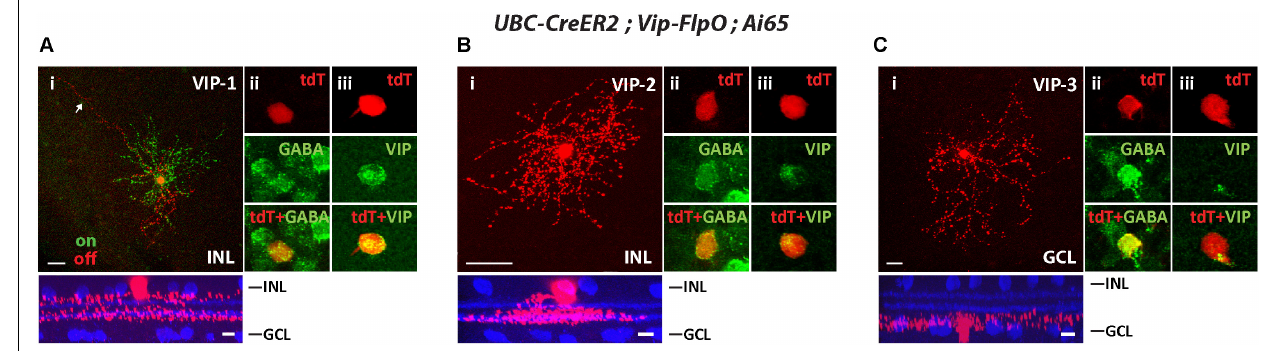
FIGURE 5 | The Vip-FlpO driver targeted 3 types of ACs. The Vip-FlpO driver was crossed with UBC-CreER2 and Ai65, 20 µ g tamoxifen was administered to achieve sparse labeling of ACs. Representative images for VIP-1 AC (A) , VIP-2 AC (B) , and VIP-3 AC (C) are shown in flat-mount view (top) and side view (bottom) with ChAT (blue) in (i) . Arrow in (Ai) shows the “tail” of the VIP-1 AC. Sections were co-labeled with antibodies against GABA (green) (ii) and VIP (green) (iii) . Scale bar: 25 µ m for flat-mount view, 10 µ m for side